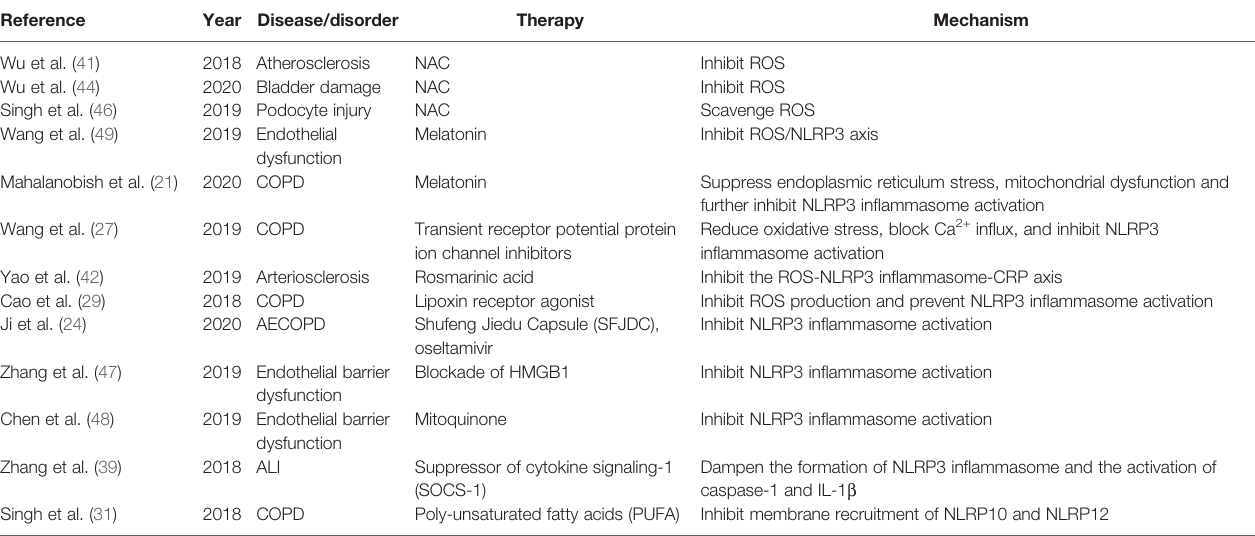
TABLE 2 | Therapeutic strategies to target in fl ammasome in cigarette smoke-induced diseases and physiopathological disorders.